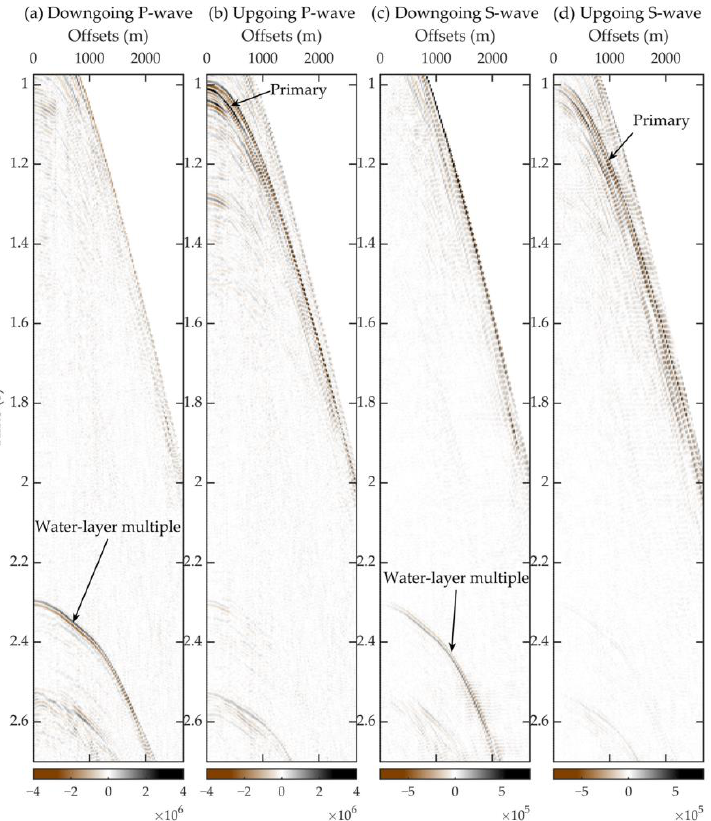
Figure 15. The ( a ) downgoing P-potential, ( b ) upgoing P-potential, ( c ) downgoing S-potential and ( d ) upgoing S-potential decomposed just below the seafloor (mostly positive-offset areas between primary events and the first-order water-layer multiple events). The colormaps for ( a , b ) P-potential and ( c , d ) S-potential are respectively unified. The direct wave and the first-order water-layer multiple in ( a , c ) downgoing potentials and primary events in ( b , d ) upgoing potentials are indicated by the black arrows.